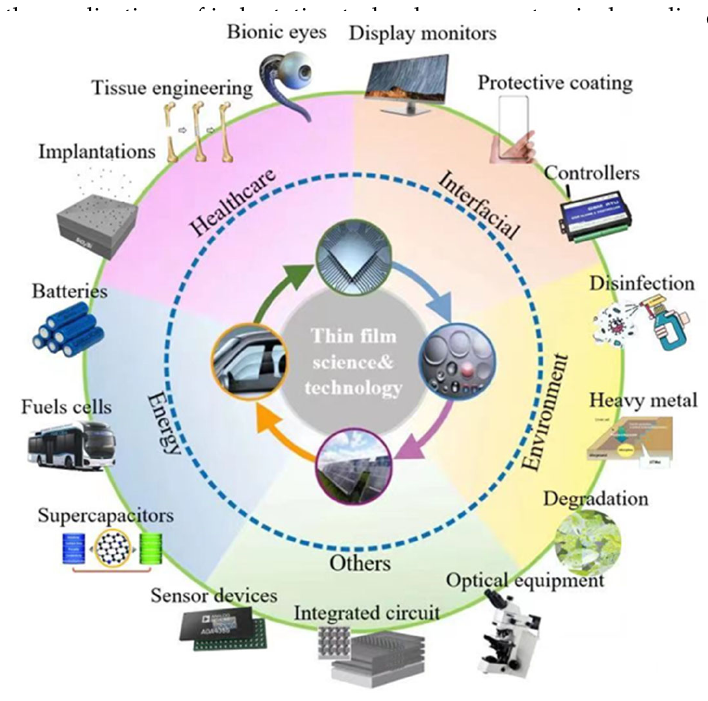
Figure 1. Schematic diagram of thin ‐ film applications in various areas.